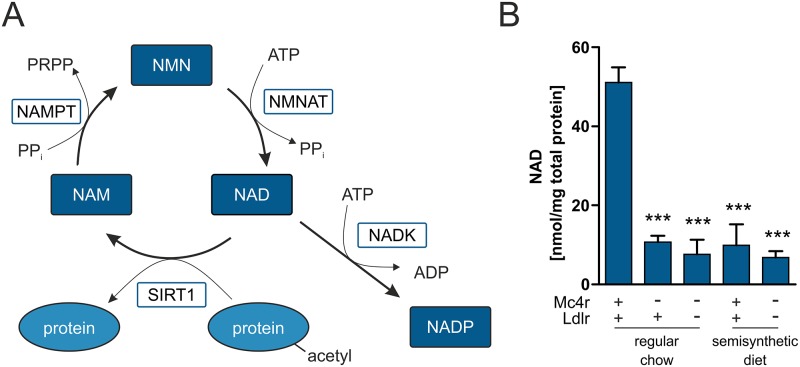
NAD is reduced in livers of genetically modified compared to wild-type mice.(A) Schematic overview of the Sirt1-NAD salvage pathway and involved components. (B) NAD was quantified using reversed-phase HPLC. Data represent means ± SEM. Significance levels were calculated by one way analysis of variance followed by Bonferroni post hoc test (n = 6).